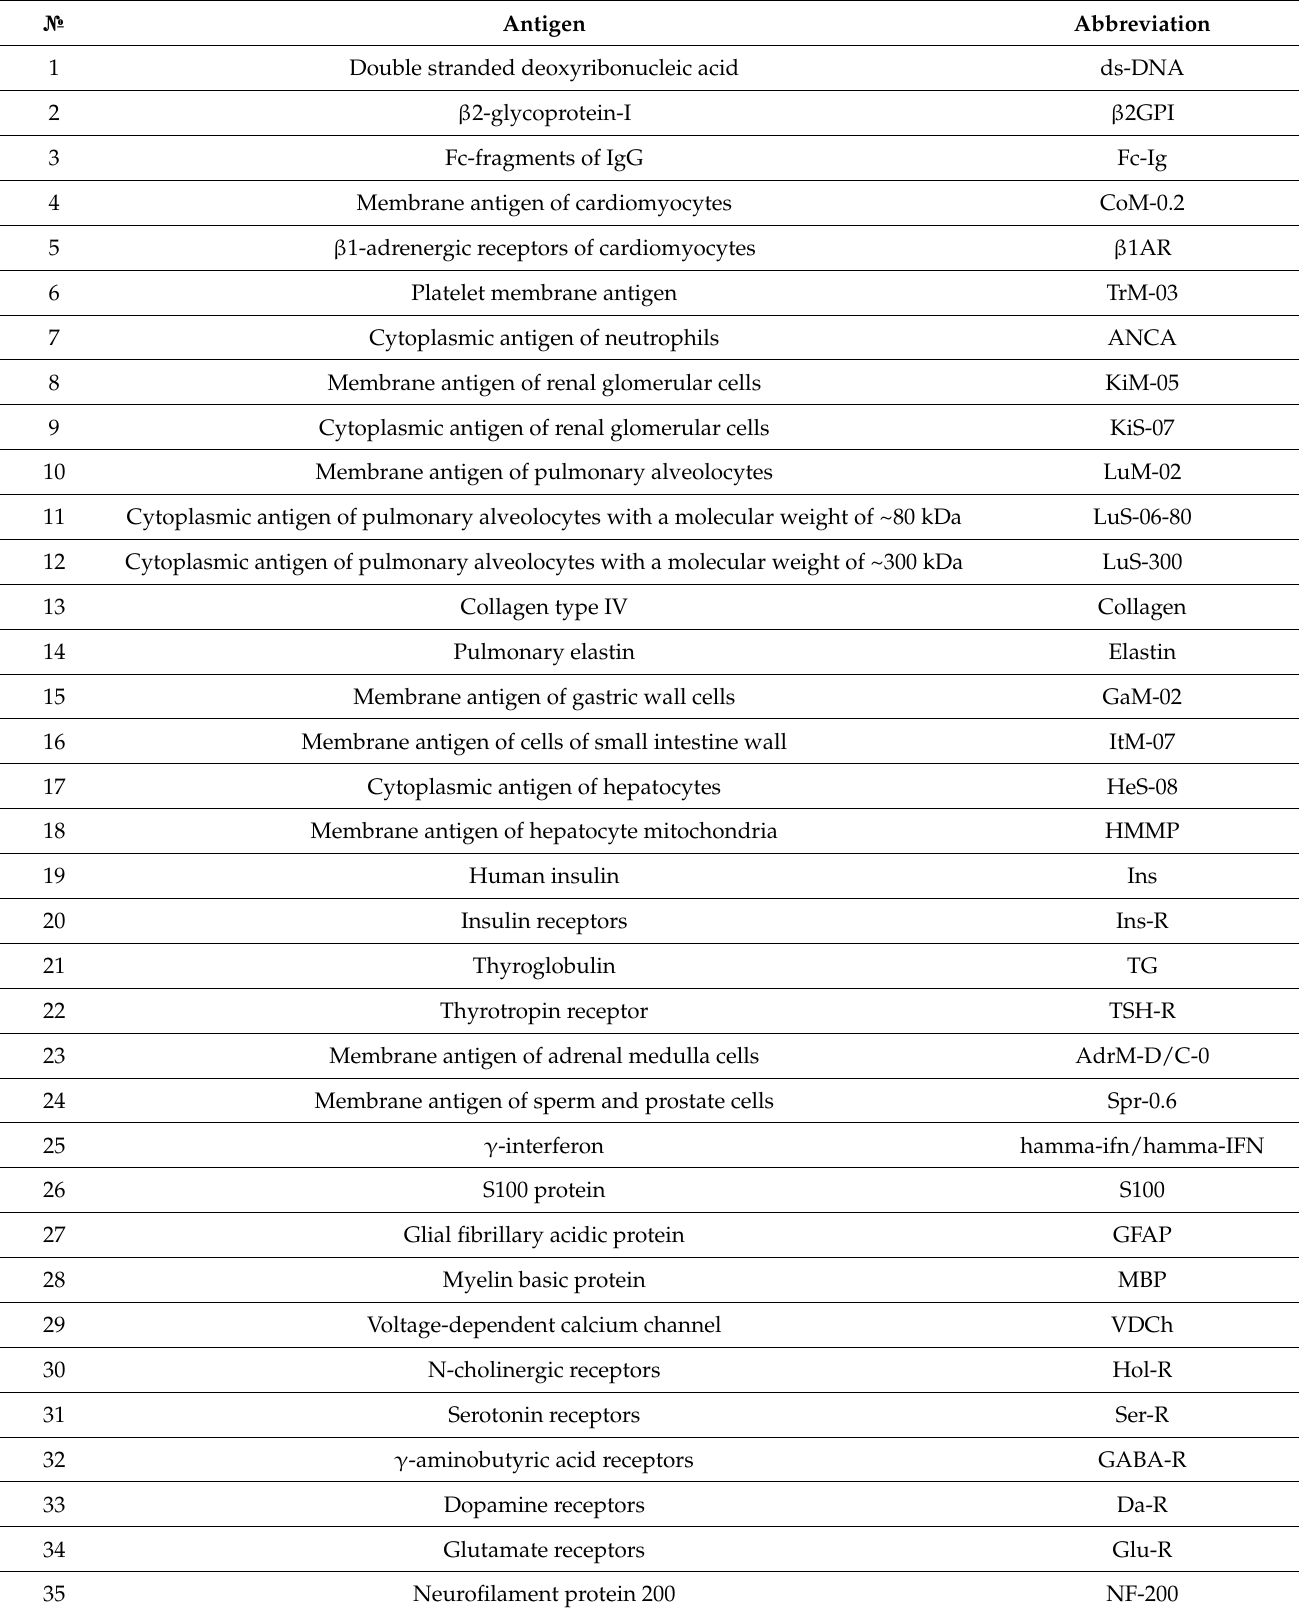
Table 1. List of antigens, which autoantibodies were